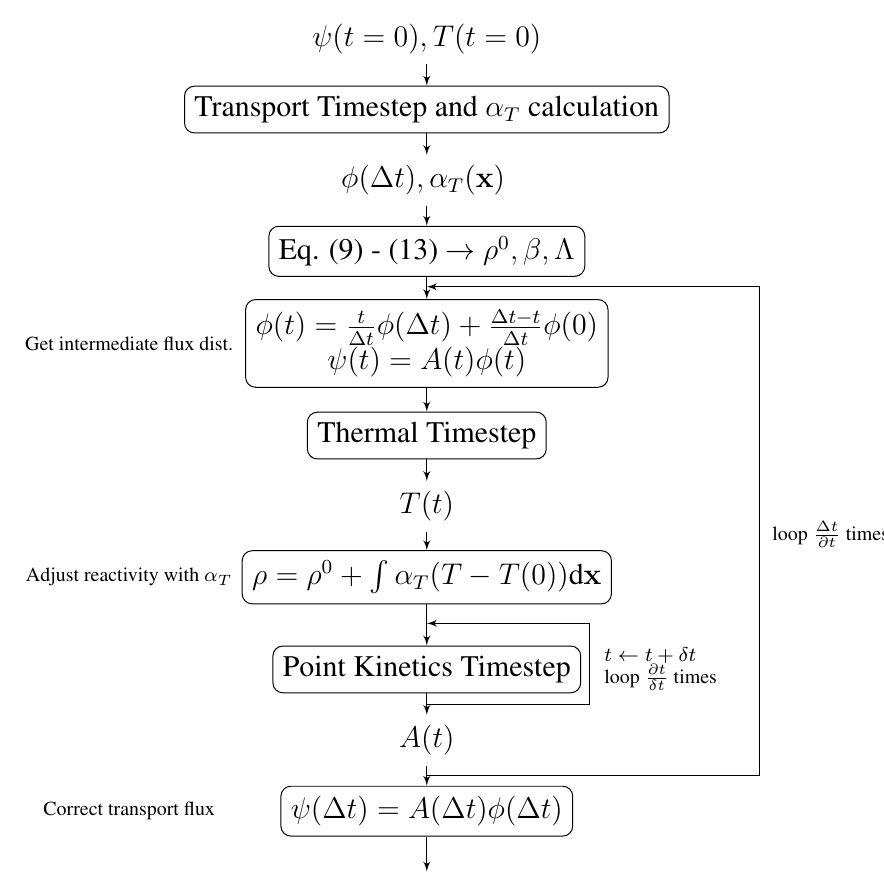
Figure 1. Flowchart of single PCQS iteration with our multiphysics coupling